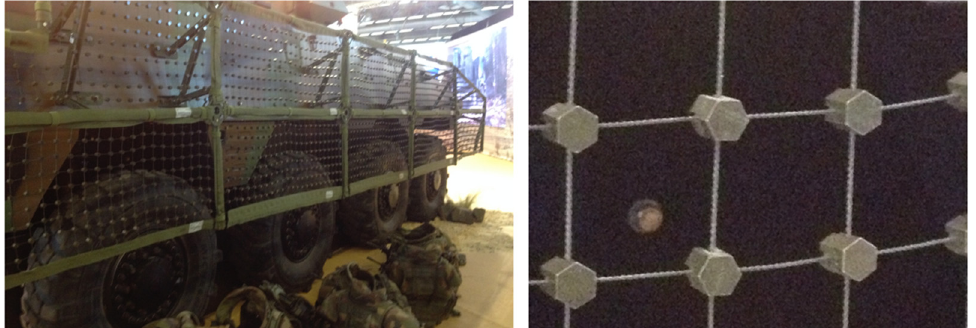
Figure 10. Inertial distributed weight cage armour system.